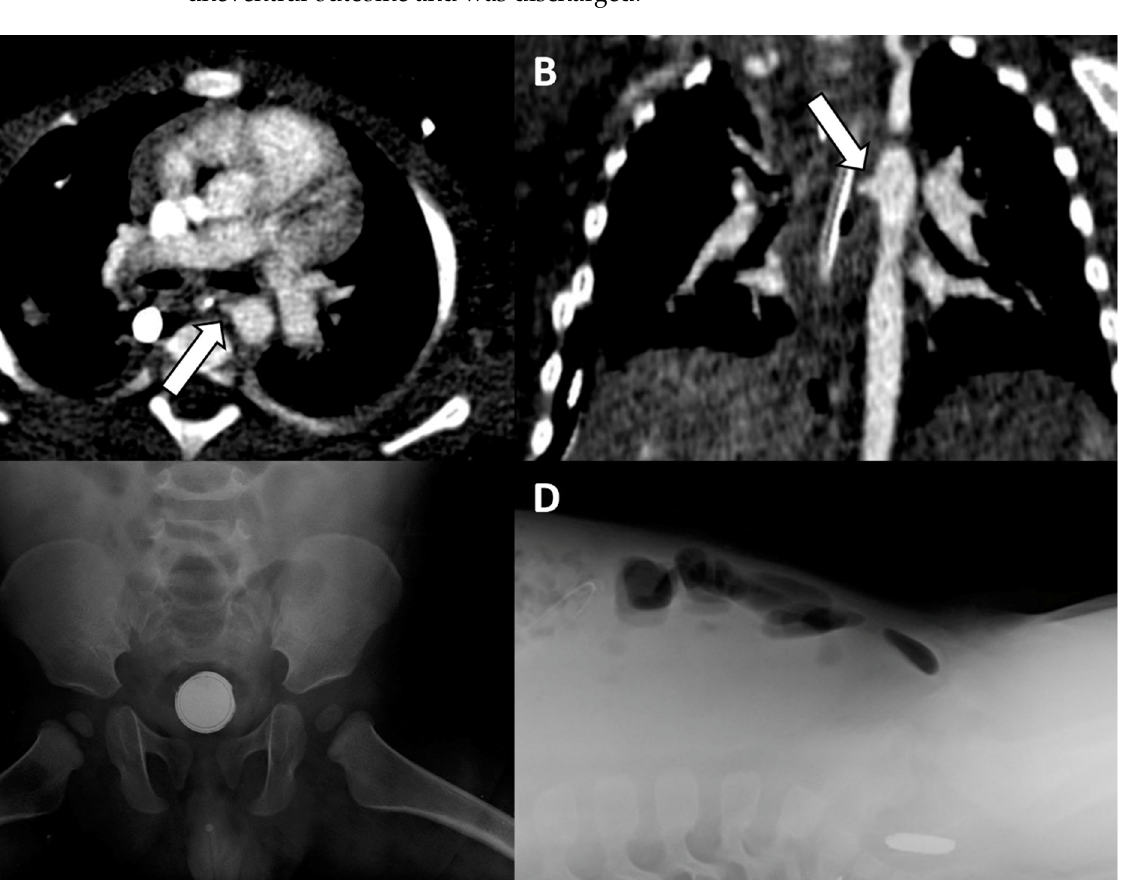
Figure 2. Contrast ‐ enhanced CT angiography images along the axial ( A ) and coronal ( B ) planes, Figure 2. Contrast-enhanced CT angiography images along the axial ( A ) and coronal ( B ) planes, showing the aorto ‐ esophageal fistula ( arrows ). Antero ‐ posterior ( C ) and lateral ( D) X ‐ rays of the showing the aorto-esophageal fistula ( arrows ). Antero-posterior ( C ) and lateral ( D) X-rays of the abdomen demonstrate the presence of a metallic foreign body with “double ‐ ring” and “step ‐ off” abdomen demonstrate the presence of a metallic foreign body with “double-ring” and “step-off” signs in the pelvic region, suggestive of disk battery in the rectum. signs in the pelvic region, suggestive of disk battery in the